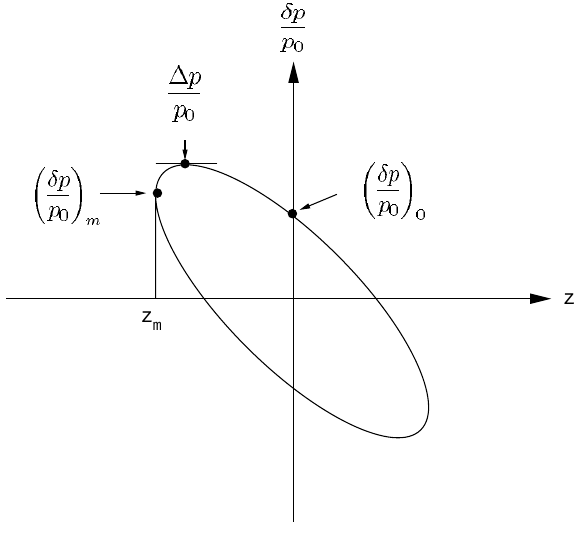
FIG. 1. Definition of parameters for a rotated ellipse in the fast compression